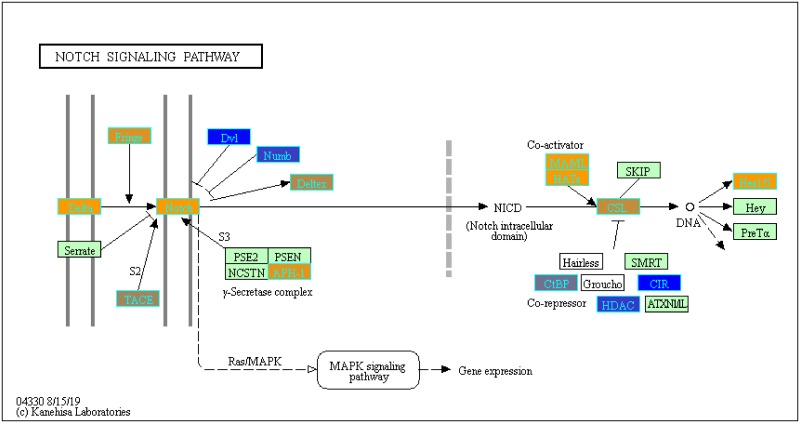
Highlighted notch signaling KEGG pathway (hsa04330)with enriched genes from the LRT (q-value < 0.05) [49–51].Yellow-colored genes are up-regulated and blue-colored genes are down-regulated in COPD samples.